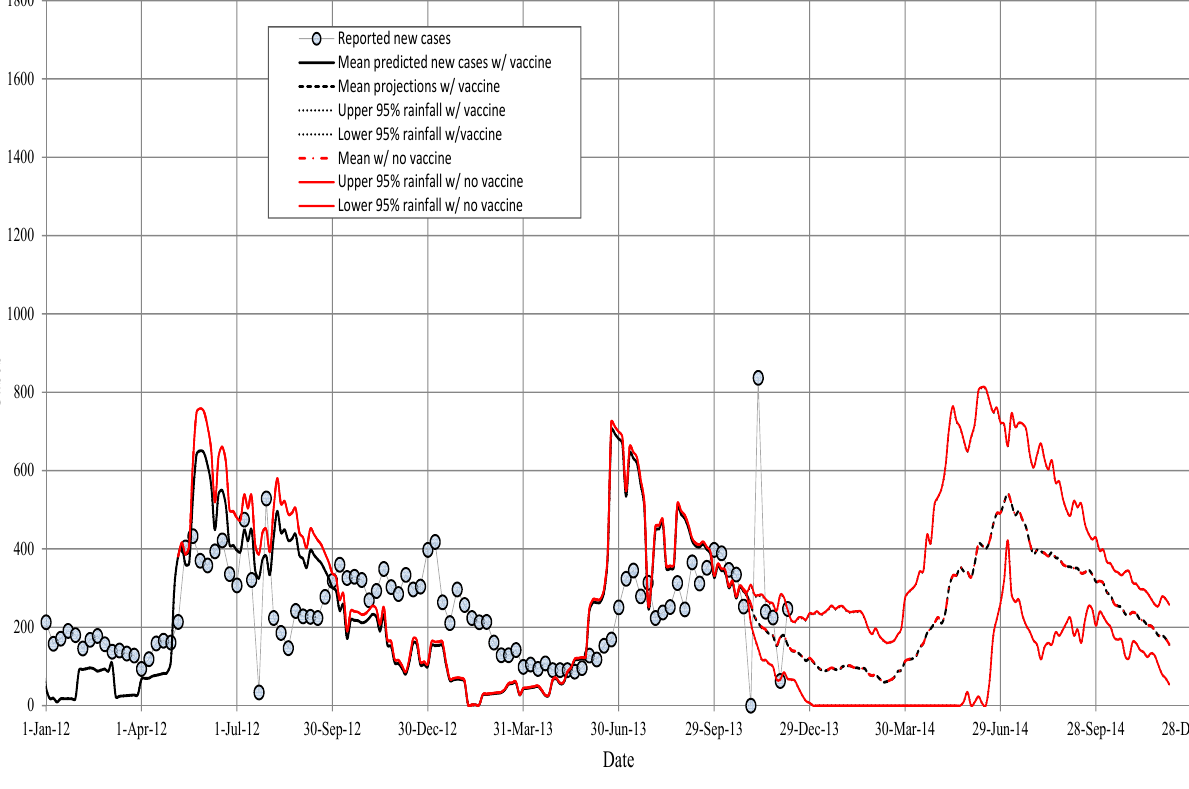
Figure 9. Artibonite. The projected new symptomatic individuals vs . time. Circles, observed; solid line, model prediction; dashed lines, 95the percentile confidence intervals for model projections. The red line is projections with 75 percent vaccine efficacy. Projected and Reported Number of New Cases per Week vs Time Artibonite (1 January 2012 to 7 December 2014) Reported new cases Mean predicted new cases w/ vaccine Mean projections w/ vaccine Upper 95% rainfall w/ vaccine Lower 95% rainfall w/vaccine Mean w/ no